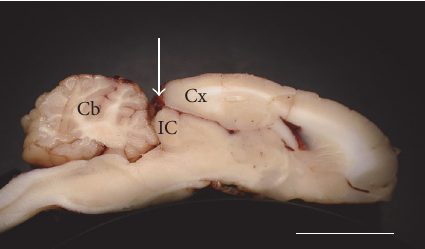
Figure 1: Following surgery the inferior colliculus (IC) is visible for direct dorsoventral electrode placement (indicated by arrow), while the integrity of cortex (Cx) and cerebellum (Cb) are maintained. Sagittal sections through IC were obtained upon completion of recordings. Scale bar indicates 1cm.